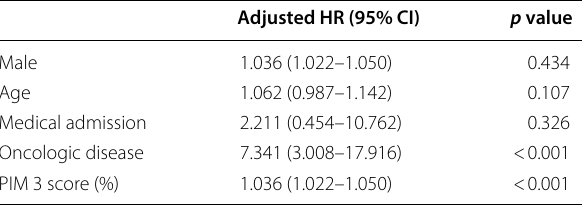
Variables included in the regression test were age, sex, PIM 3 score at admission, admission type (surgical or medical), and presence of underlying oncologic